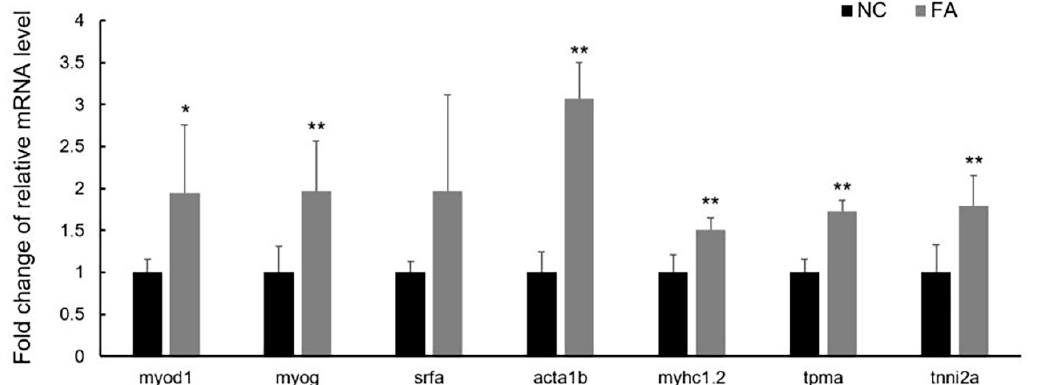
Figure 4. Effects of ferulic acid on gene transcription of fast skeletal muscle in adult zebrafish. Raw data were calculated in 2 ∆∆ − ct method. Relative mRNA expression level of genes in the FA group was shown as fold change after being normalized to the NC group. NC: negative control group; FA: ferulic acid administered group. Data is expressed as mean ± SD ( n = 5, per group from Population 2), * p < 0.05, ** p < 0.01 when compared to the NC group.